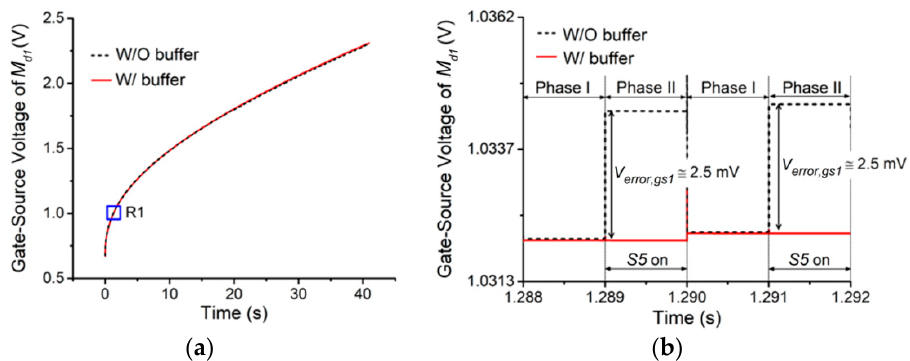
Figure 6. Post-layout simulation results: ( a ) gate-to-source voltage of M d 1 while varying the current data from 0.1 to 200 µA; ( b ) magnified view of region R1.